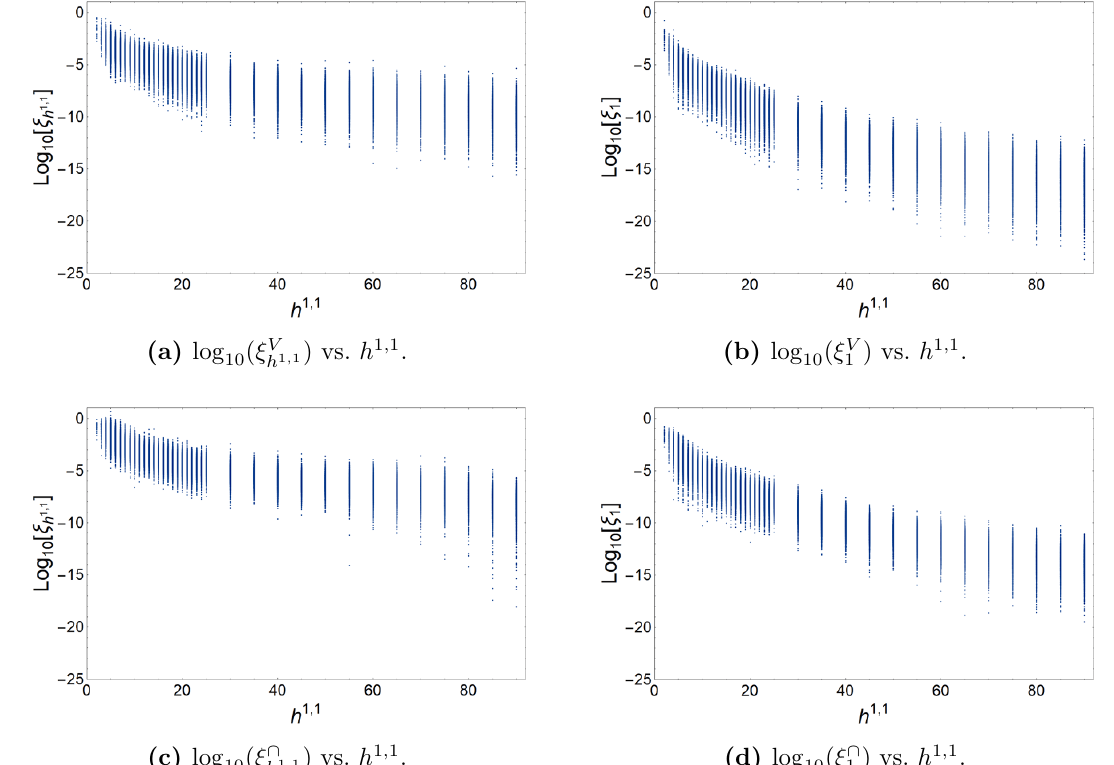
Figure 11. Maximum (left) and minimum (right) eigenvalues of the kinetic matrix (cid:4), de(cid:12)ned in (4.18), vs. h 1 ; 1 , evaluated at t V